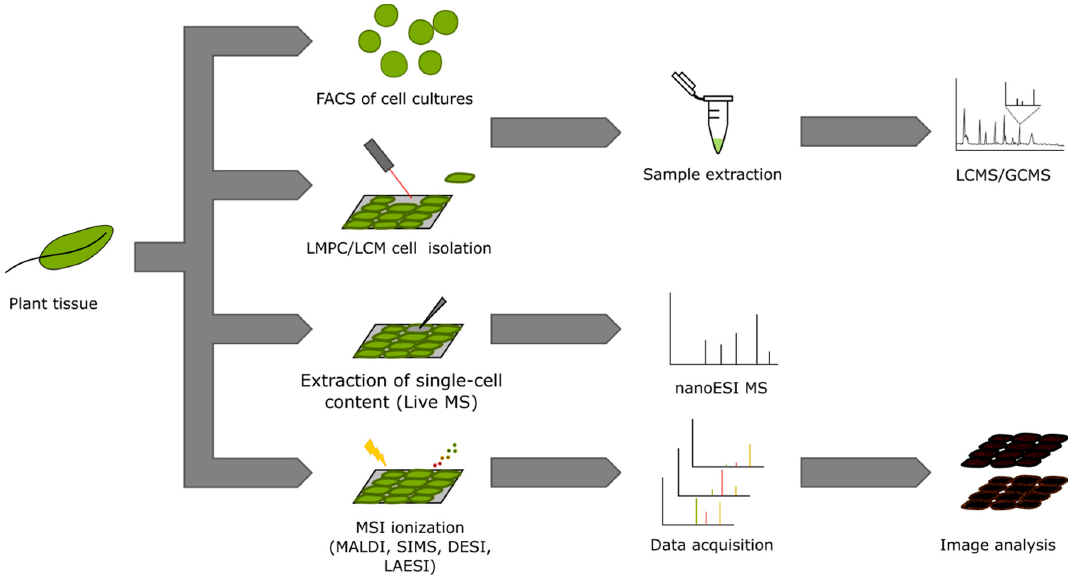
Figure 2. Overview of experimental steps and data structure from the different approaches for cell-specific metabolomics.